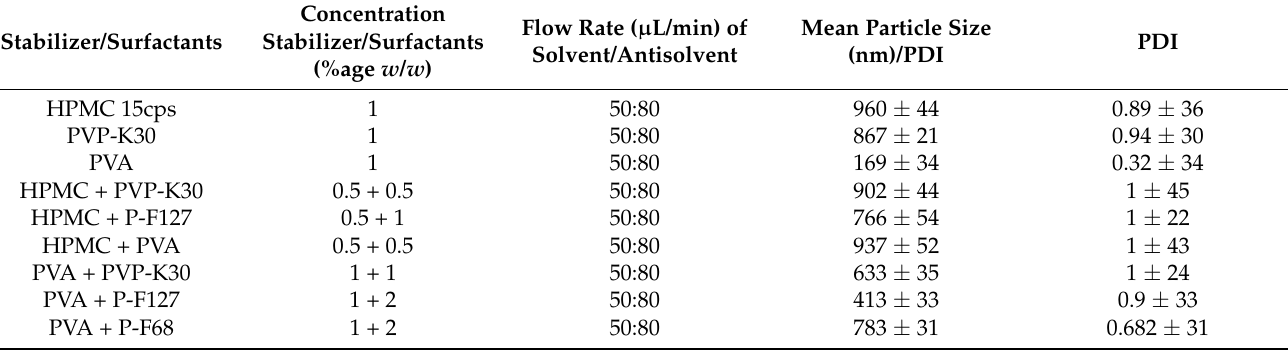
Table 1. Fabrication of Repaglinide